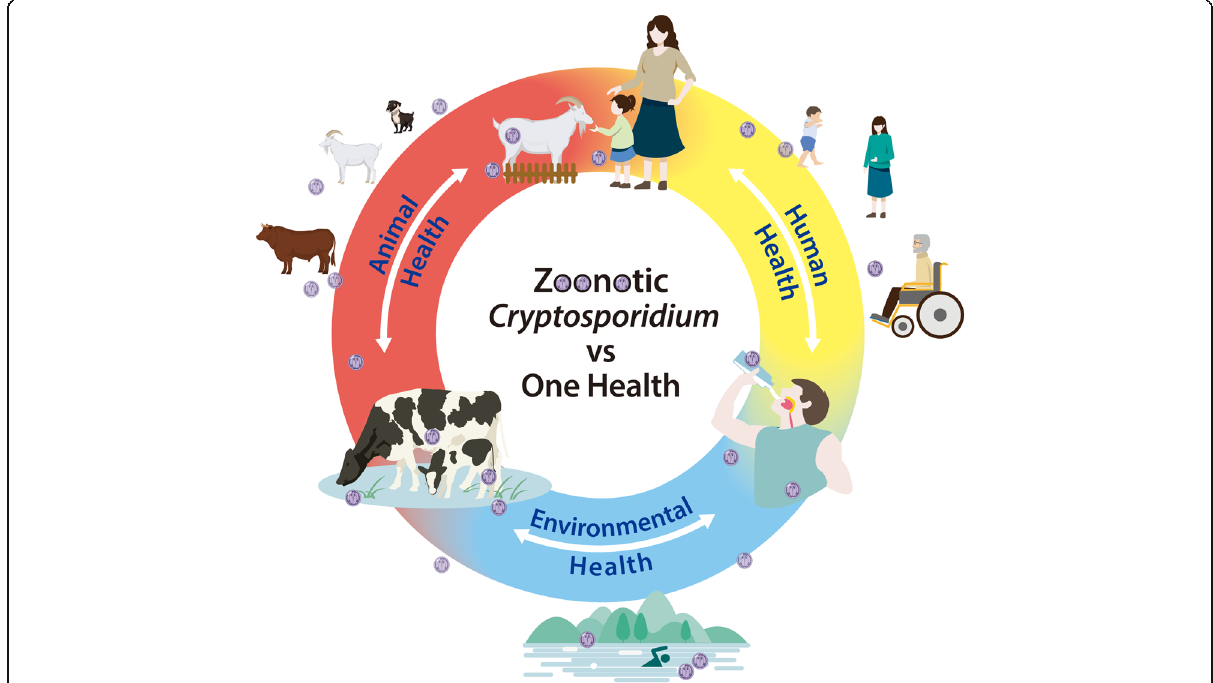
Fig. 1 Interactions and impact of Cryptosporidium on human, animal and environmental health under the One Health concept. The stress- resistant oocysts play a central role in transmission of cryptosporidial infections between and among humans and animals via direct contact and/ or contamination of environment. Credit to Lin Xia and Wenjuan Wang for